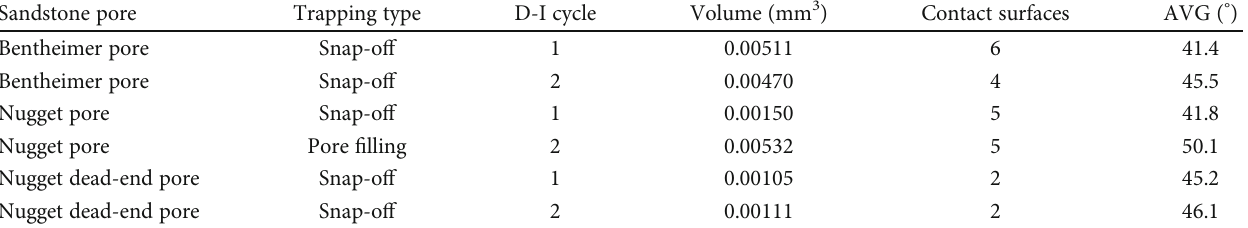
Table 2: Detailed pore